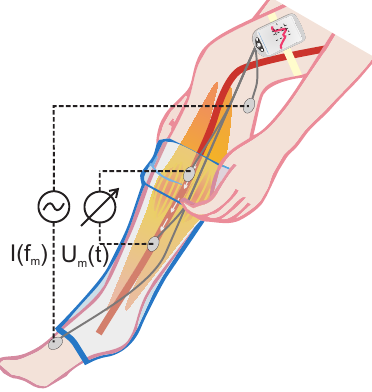
Fig.1: System concept of the semi-capacitive impedance phlebog- raphy device.